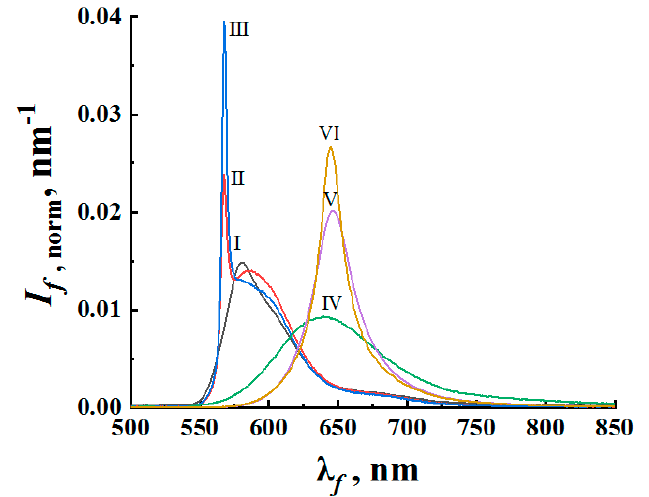
Figure 4. Evolution of the normalized fluorescence spectra with an increase in the scatter volume fraction at a fixed pump intensity. I – III – R6G-based samples #2; IV – VI – DCM-based samples #2 ( I p = 8.8 × 10 7 W/cm 2 ). ρ = 0 (I, no particles); ρ ≈ 0.0073 (II); ρ ≈ 0.012 (III); ρ = 0 (IV, no particles); ρ ≈ 0.014 (V); ρ ≈ 0.026 (VI).